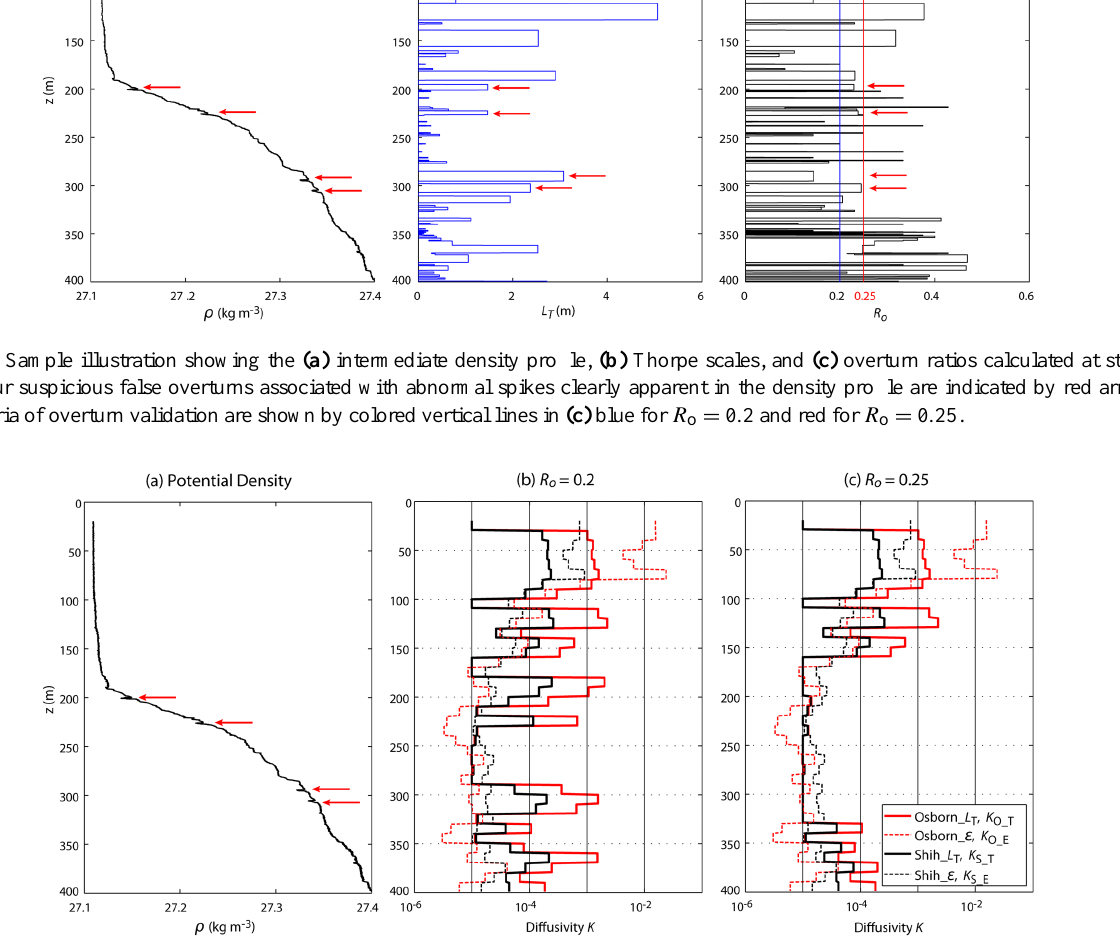
Figure 4. Different diffusivity profiles at station A3-1 calculated with different pairs of parameterization (Osborn or Shih) and observational method (Thorpe scale L T or TurboMAP-derived ε) using the two overturn validation criteria of (b) R o = 0 . 2 and (c) R o = 0 . 25. Note that the four abnormal spikes seen in (a) , being the repetition of Fig. 3a, give rise to great overestimation in the Thorpe-scale-derived diffusivities with R o = 0 . 2, but this feature disappears completely with R o = 0 .